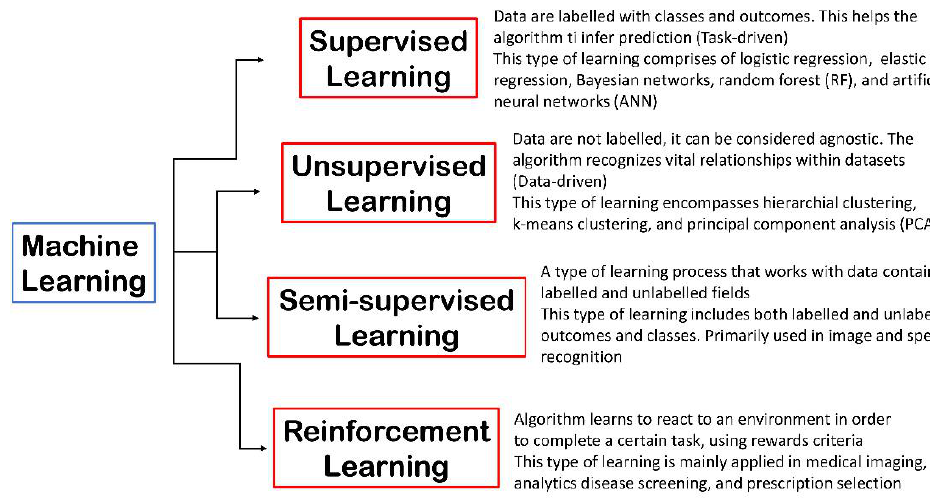
Figure 3. ML is mainly classified into four classes: supervised learning, semi-supervised learning, unsupervised learning, and reinforcement learning.